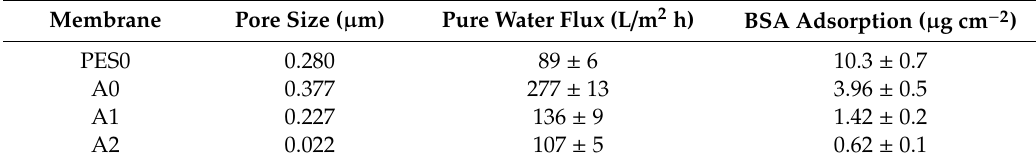
Table 4. Pore size, pure water permeation, and protein adsorption data for the fabricated membranes. Membrane